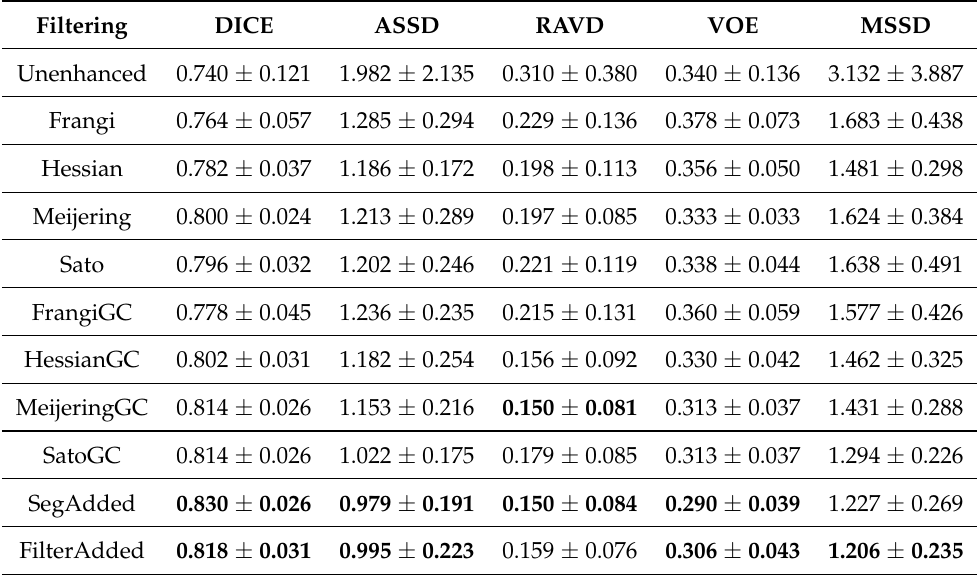
Table 1. Mean and standard deviation values for Segmentation metrics with different filtering.